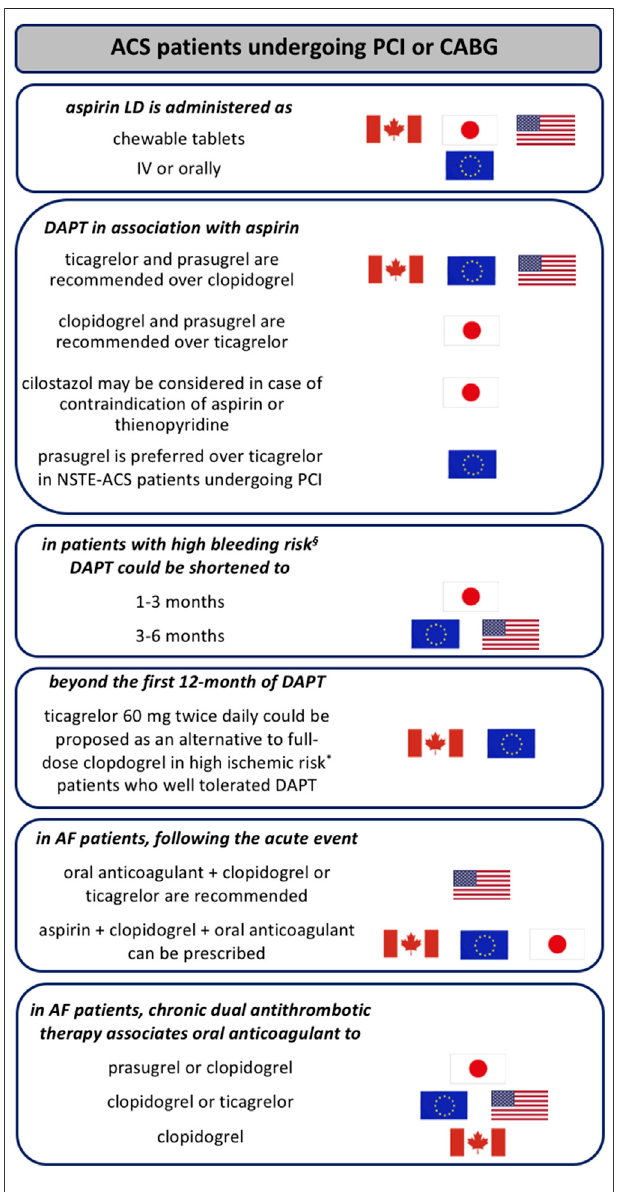
FIGURE 1 | Main differences in antiplatelet therapy recommendations in ACS patients across guidelines. § in case of history of prior bleeding, oral anticoagulant therapy, female sex, advanced age, low body weight, chronic kidney disease, diabetes mellitus, anemia, chronic steroid or nonsteroidal anti-in fl ammatory drugs (NSAID) therapy (American guidelines); having PREdicting bleeding Complications In patients undergoing Stent implantation and subsEquent Dual Anti Platelet Therapy (PRECISE-DAPT) score ≥ 25 or meeting the Academic Research Consortium for High Bleeding Risk (ARC-HBR) criteria (European guidelines); having PRECISE-DAPT score ≥ 25 or DAPT score < 2 (given as examples since limited data are available to evaluate the applicability of these scoring systems to the Japanese population; Japanese guidelines). * having at least one clinical (prior